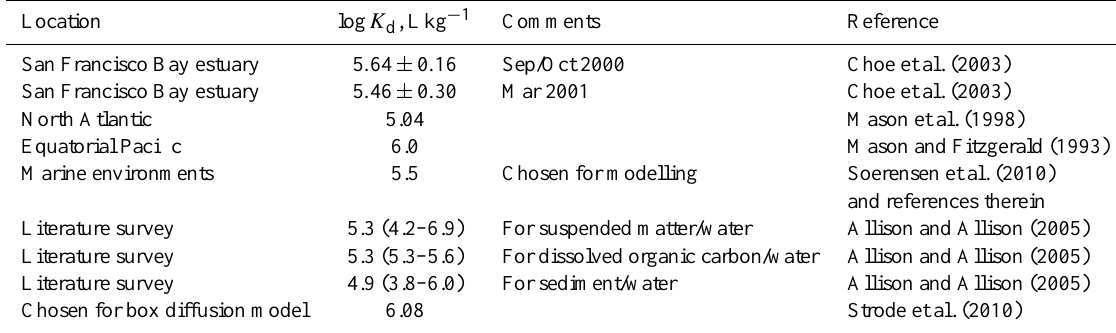
Table 4. Coefficients of mercury water-particle partition in